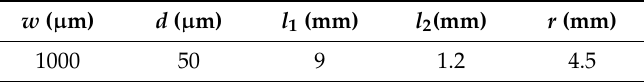
Table 1. Main design parameters.